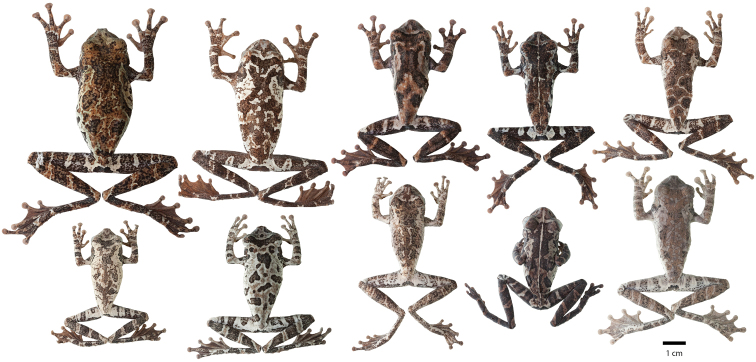
Adult Osteocephalus cannatellai showing variation in dorsal coloration of preserved specimens. Left to right, upper row (dark morphs): QCAZ 49439, 31051 (females), 40258, 49022, 45271 (males); lower row (light morphs): QCAZ 37175, 48744, 48797, 39633, 46472 (males). Ecuador, Provincia Morona Santiago, Napo, Orellana, Pastaza and Zamora Chinchipe. All specimens are shown at the same scale.